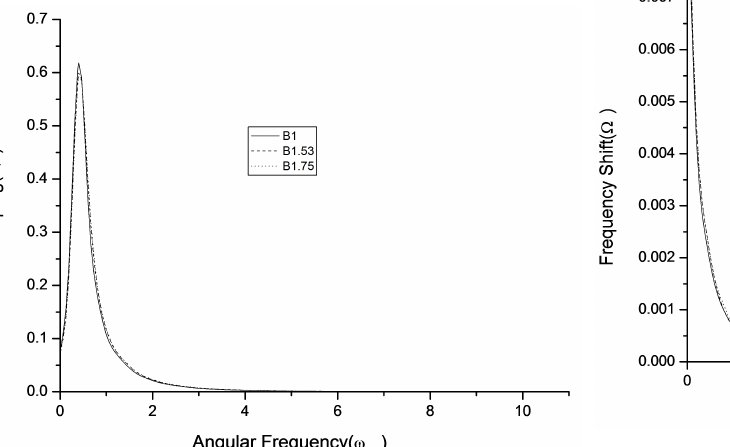
Figure 7: Variation in frequency shift with respect to angular fre- quency ( α = 0.25)